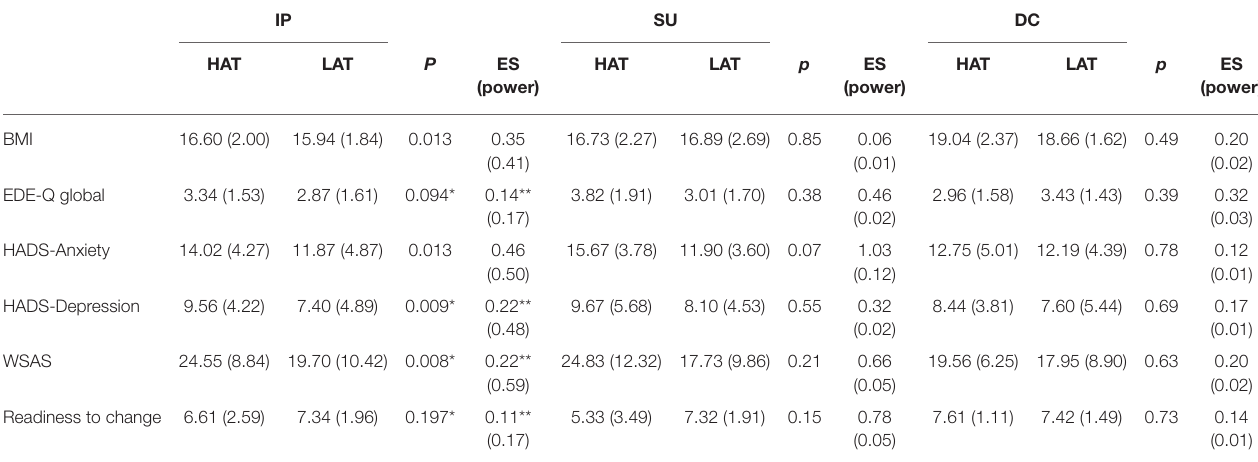
TABLE 5 | Clinical outcome data on discharge of patients with high (HAT) and low (LAT) autistic traits. IP